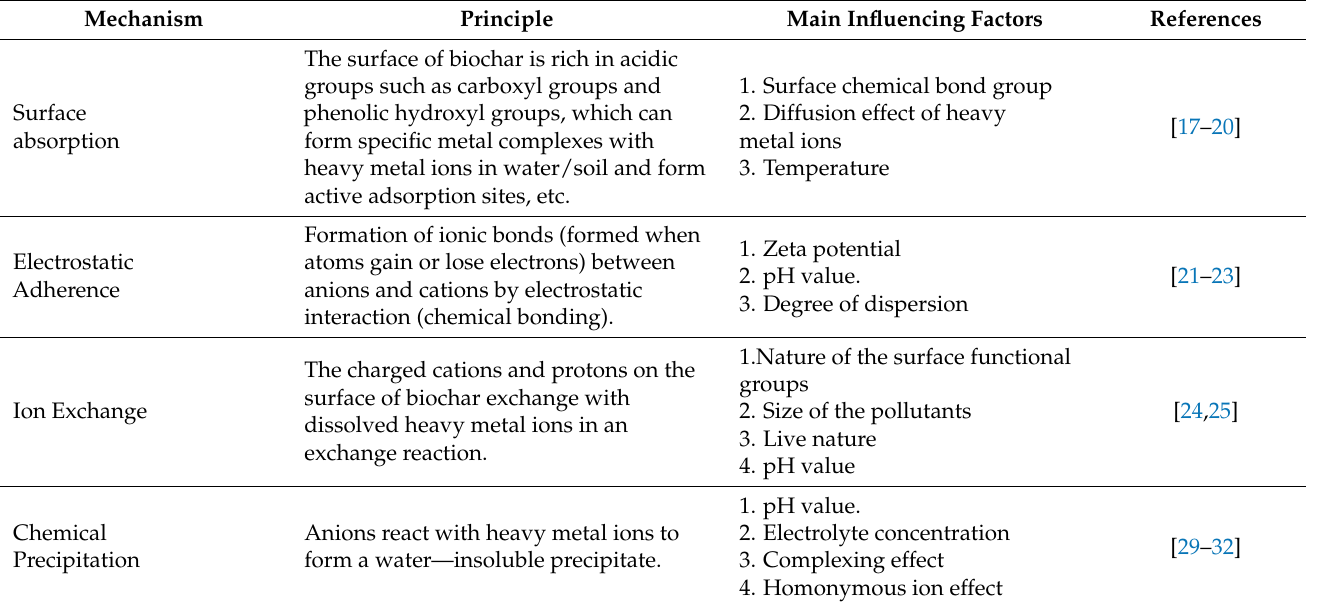
Figure 3. Schematic diagram of the behavior of biochar. Table 1. Adsorption mechanism of heavy metals by biochar and modified biochar.